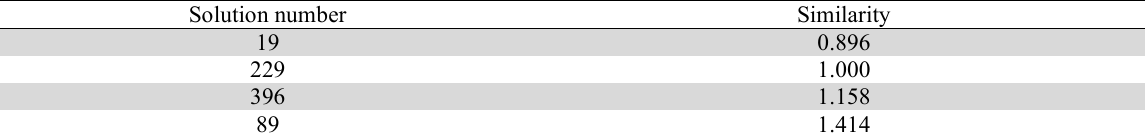
Overall similarity value on the single